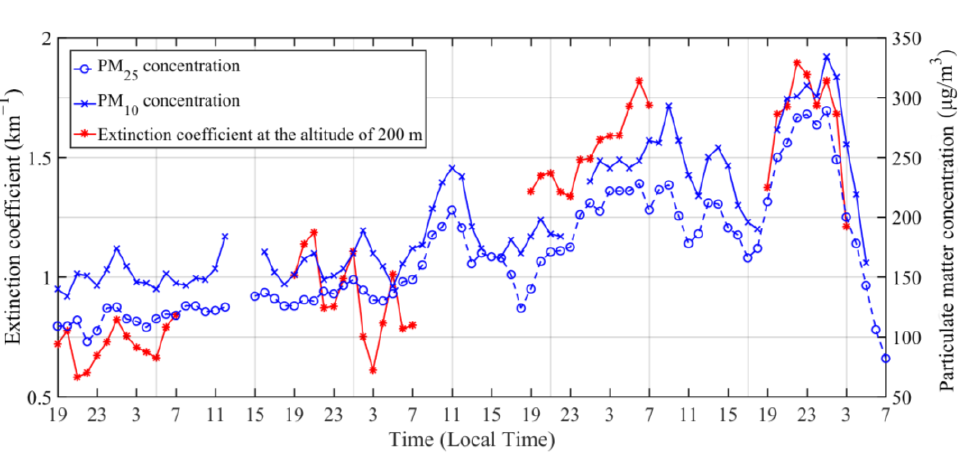
Figure 12. Comparison of aerosol extinction coefficient at the altitude of 200 m and particulate matter concentration recorded by ambient air quality monitor in haze event.